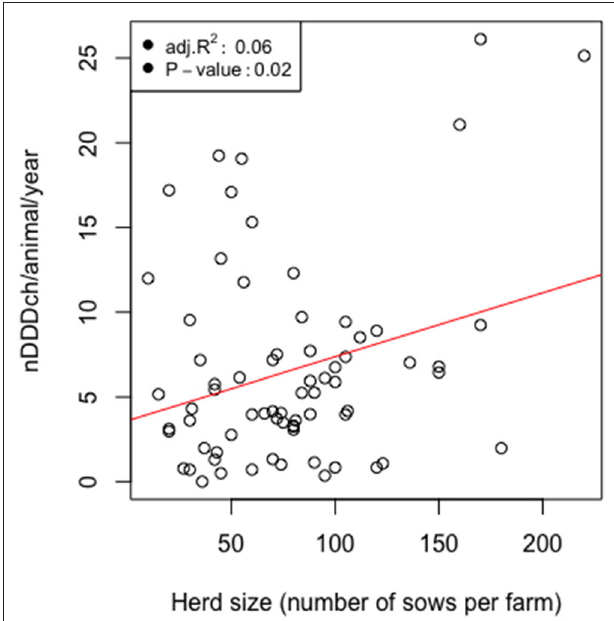
FIGURE 4 | Scatterplots and linear regressions for the relationship of the number of defined daily dose Switzerland per pig (nDDDch/animal/year) and the herd size counted as the number of kept sows for 71 farrow-to-finish pig herds in Switzerland in 2017.